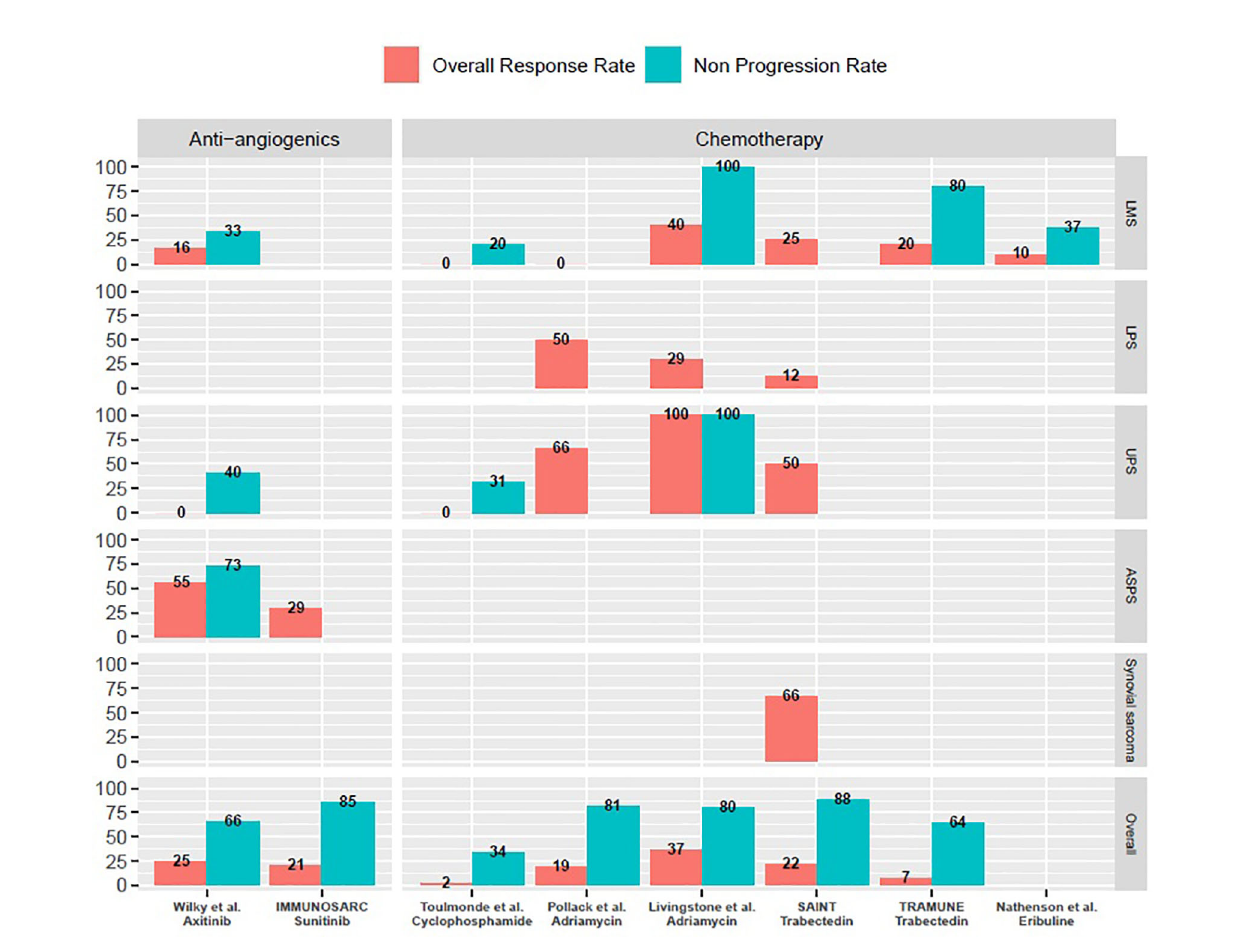
FIGURE 1 | Overall response rates and non-progression rates of selected prospective trials of combination treatments with immune-checkpoint inhibitors mentioned in the manuscript. ASPS, Alveolar soft-part sarcomas; LMS, Leiomyosarcoma; LPS, Liposarcoma; UPS, Undifferentiated pleomorphic sarcomas. M, months; w, weeks. Only cohorts including a minimum of three patients are reported on this graph. Non-progression rates are either three months progression-free survival rates or disease control rates at fi rst evaluation, as reported in speci fi c trials and mentioned throughout the manuscript